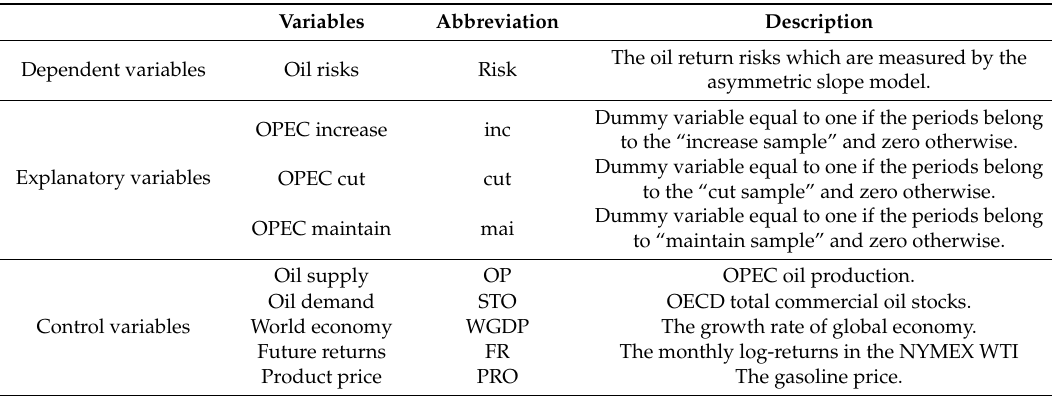
Table 2. Description of variables.